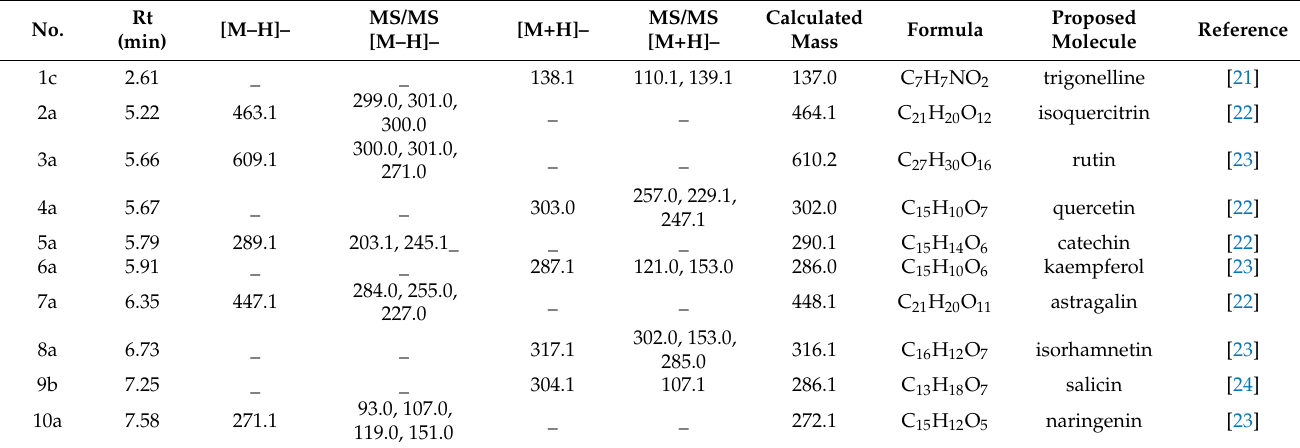
Table 5. Identification of the chemical components of TFW